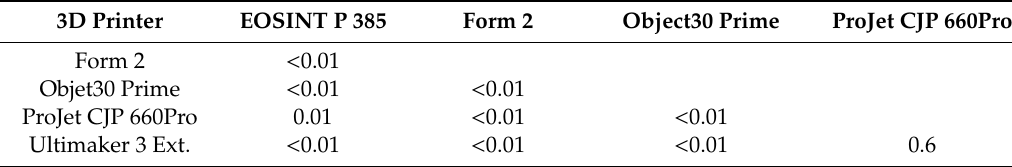
Table 4. p -values of the Tukey–Kramer post-hoc